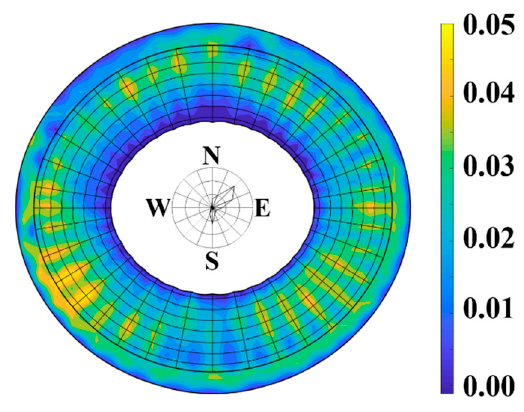
Figure 12. Distribution characteristics of the first spatial mode EOF 1 .